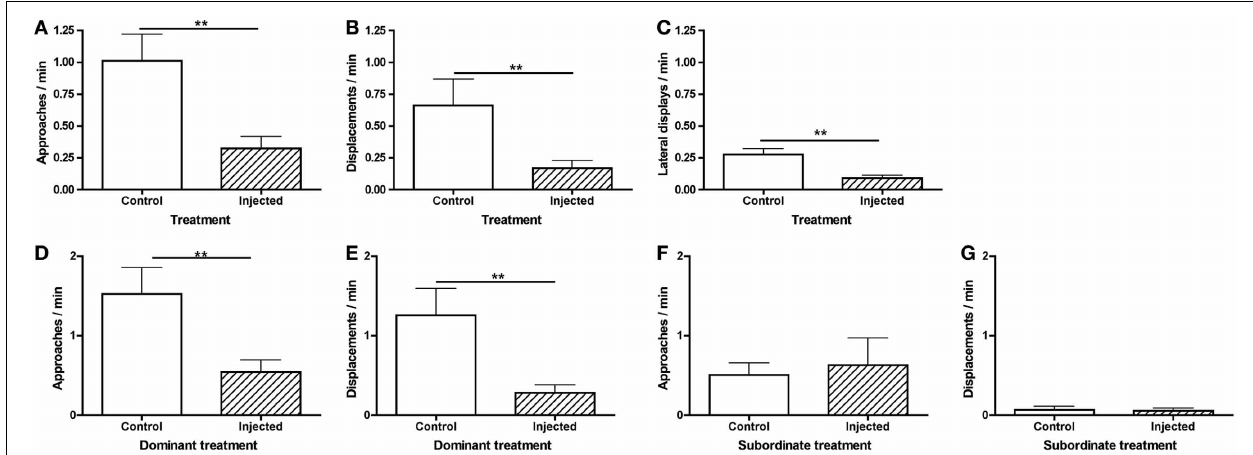
approached (independent t -test following natural log transformation: t = − 3 . 22, d . f . = 18, p = 0 . 0079) and (E) displaced (Mann–Whitney U -test: U = 9 . 0, n Inj = 7, n Con = 13, p = 0 . 0043) significantly less than control dominants. There were no significant differences in subordinate (F) approaches (Mann–Whitney U -test: U = 38 . 5, n Inj = 7, n Con = 13, p = 0 . 61) or (G) displacements (Mann–Whitney U -test: U = 36 . 5, n Inj = 7, n Con = 13, p = 0 . 50). ∗∗ p < 0 . 01.